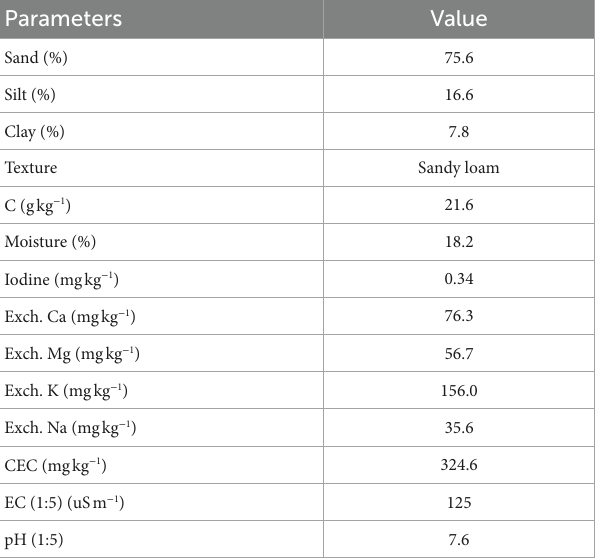
TABLE 1 Properties of soil used for the study. Parameters